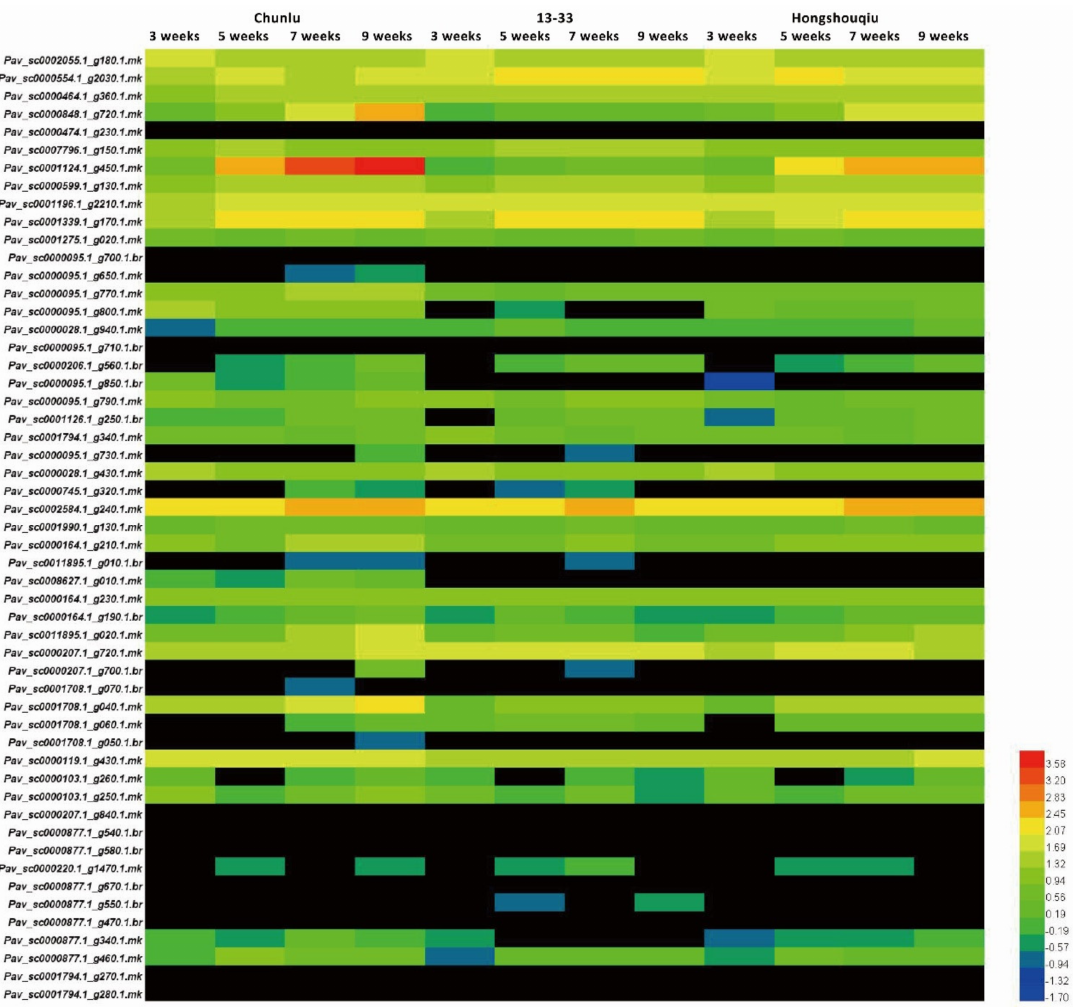
Figure 2. Expression patterns of 53 PavGST genes in developing fruits of sweet cherry varieties Chunlu, Hongshouqiu, and